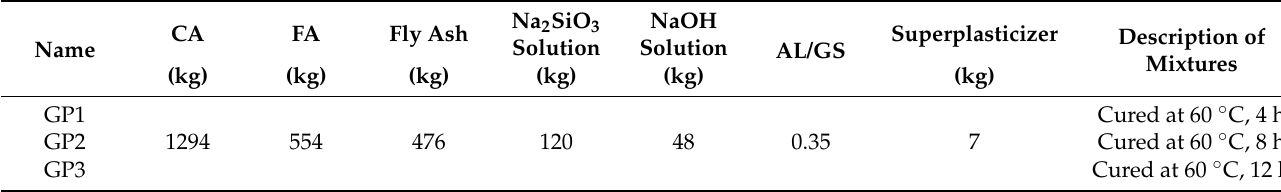
Table 2. Mixture proportions of this research.